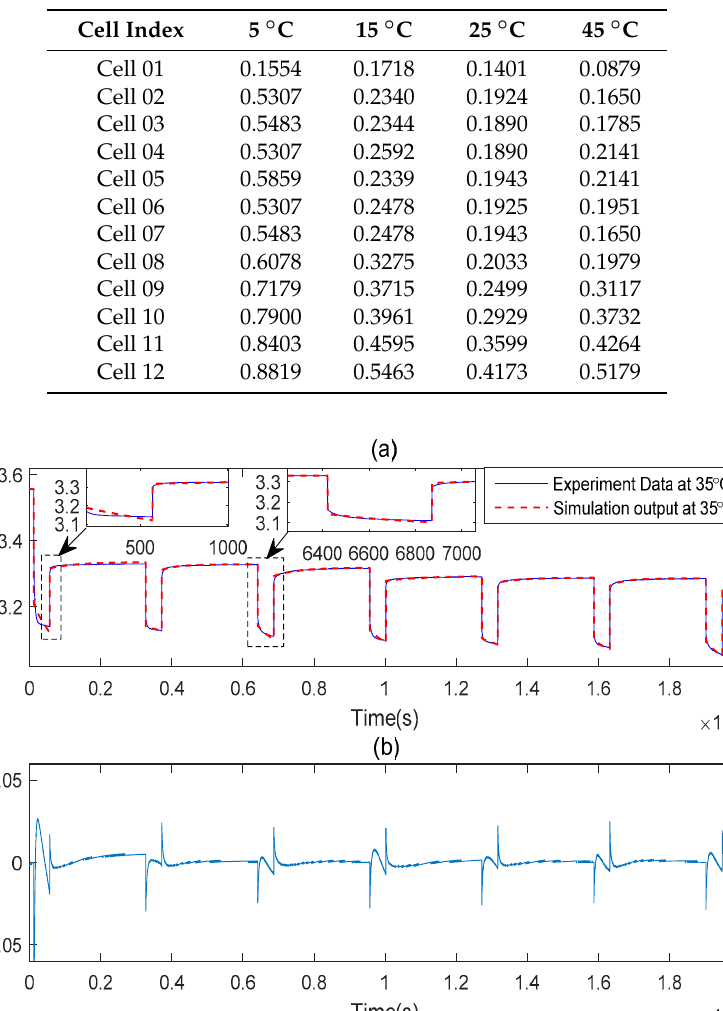
Figure 5. Simulation model of single battery cell in Simscape [67]. Table 5. RMSE between simulation and experiment of terminal voltage in per-unit basis (percentage).